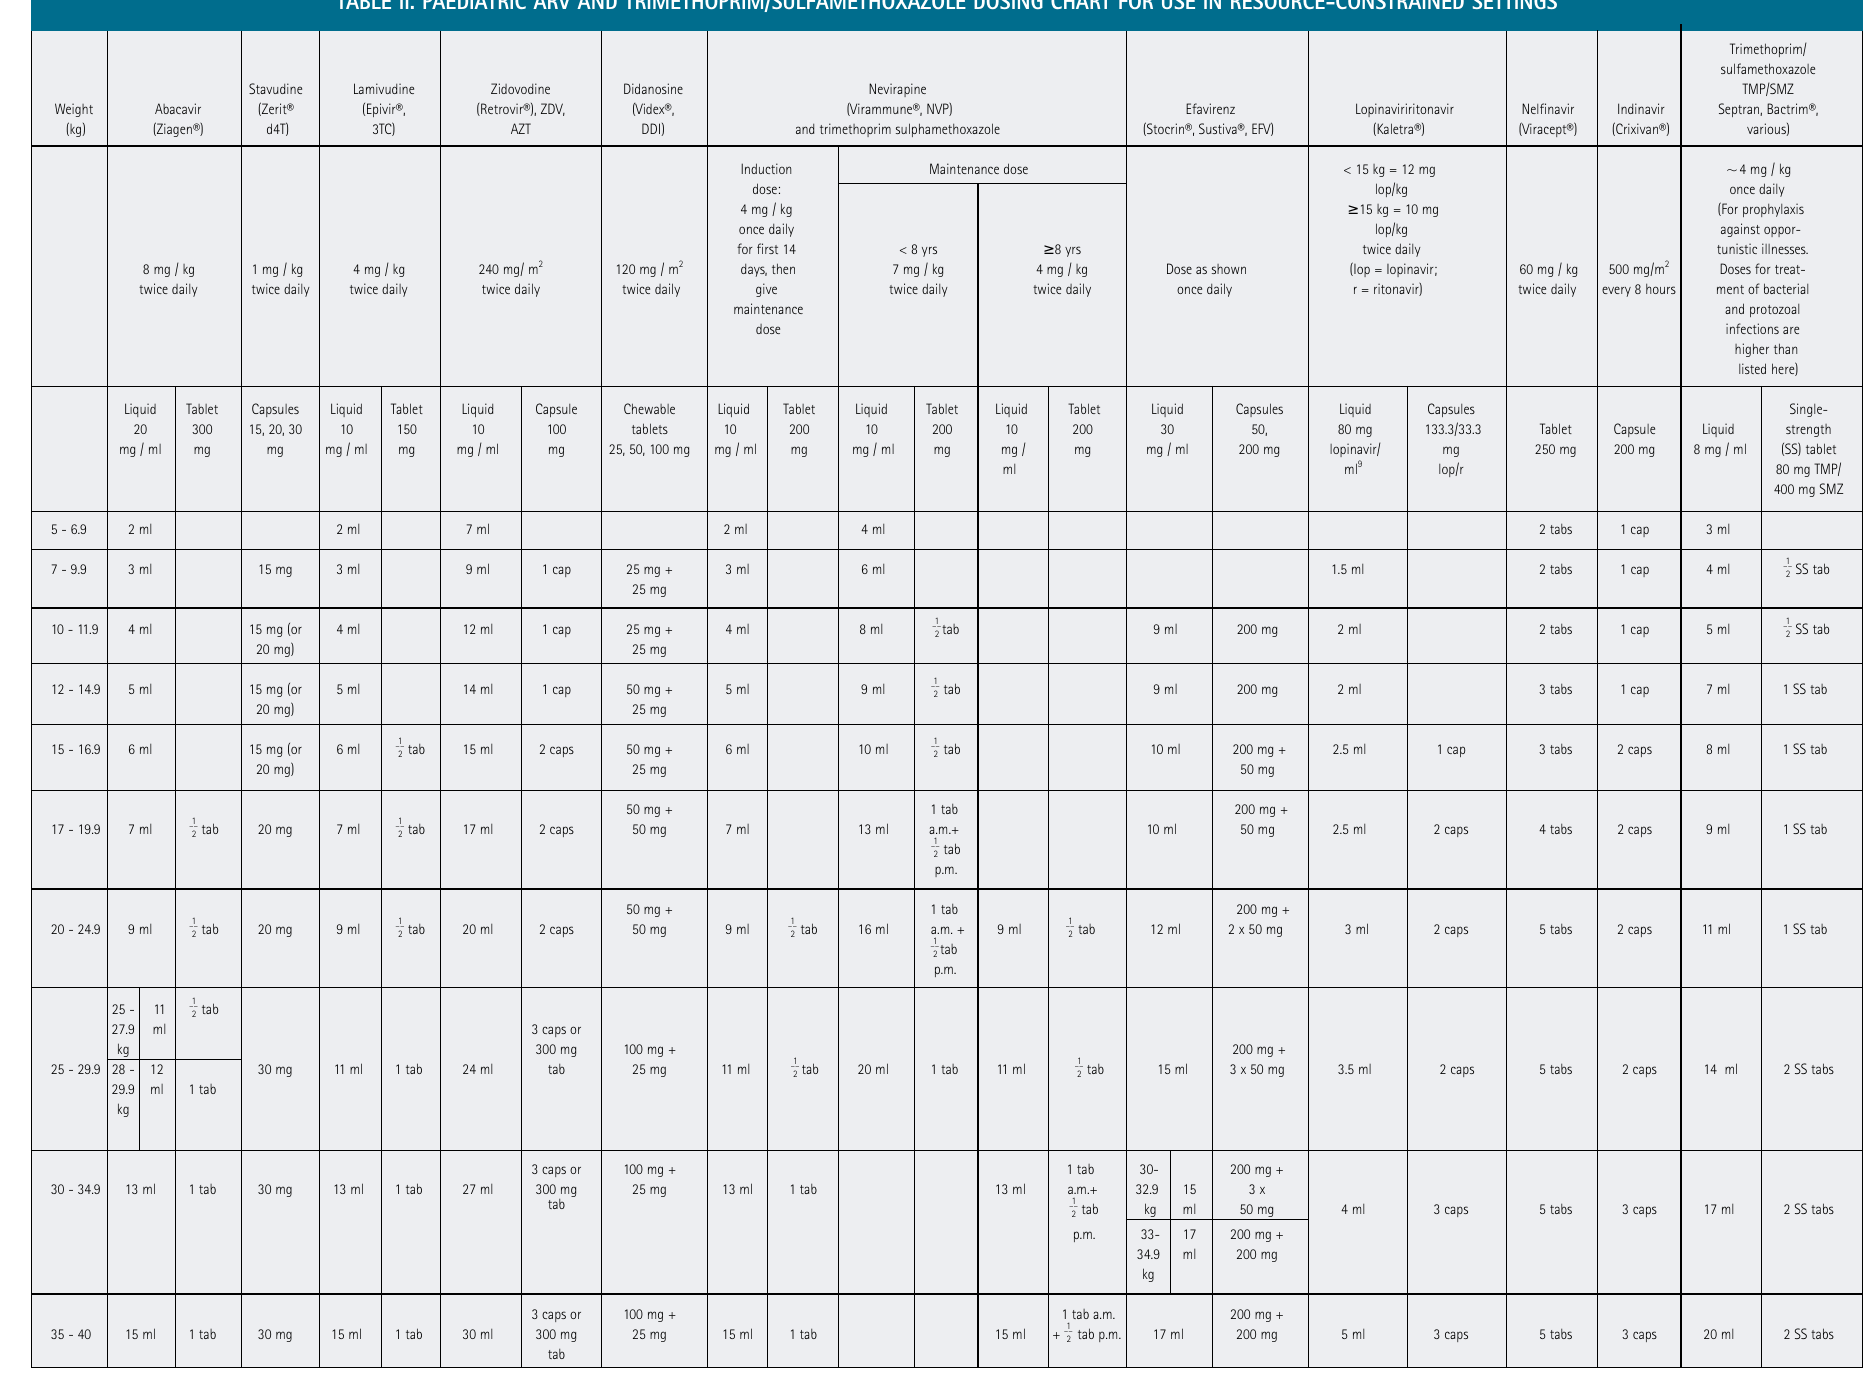
TABLE II. PAEDIATRIC ARV AND TRIMETHOPRIM/SULFAMETHOXAZOLE DOSING CHART FOR USE IN RESOURCE-CONSTRAINED